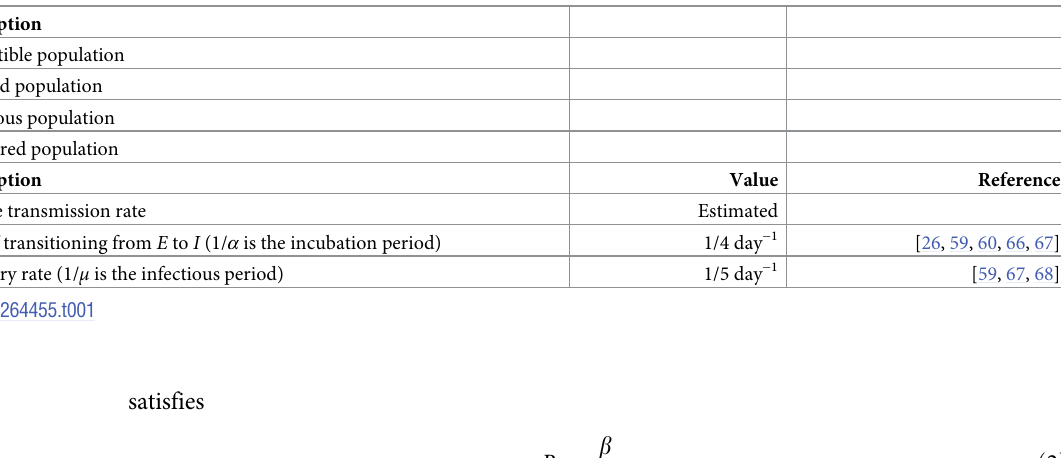
Table 1. Model variables, parameters, descriptions and